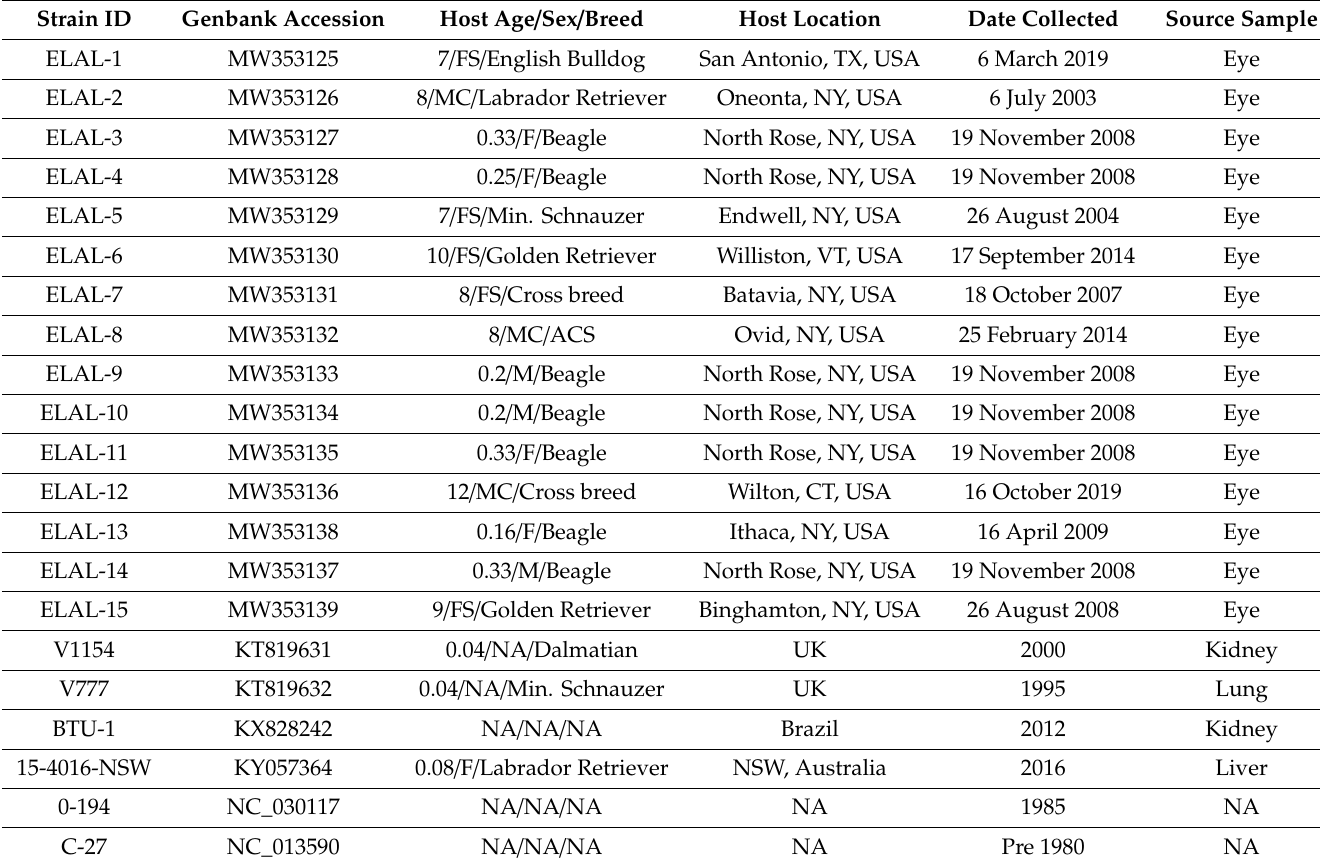
Table 1. Details of isolates included in analysis. All isolates are canid alphaherpesvirus (CHV-1) apart from C-27, which is feline herpes virus 1 (FHV-1). M = Male, F = Female, FS = Female, spayed, MC = Male, castrated, ACS = American Cocker Spaniel, NA = not applicable /